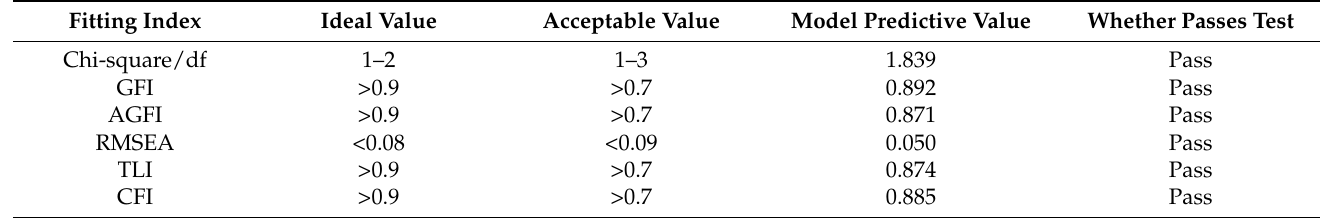
Table 2. Tests of structural equation model fit indices.